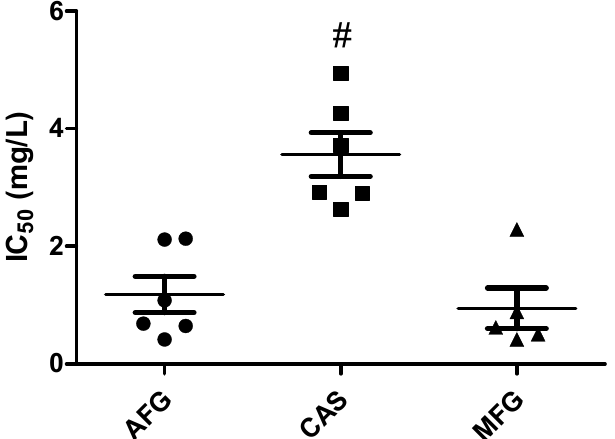
Figure 2. IC 50 values determined by Greco model for each echinocandin and clinical strain. Mean and standard errors are plotted (#, p < 0.001 compared to anidulafungin (AFG) and micafungin (MFG)).